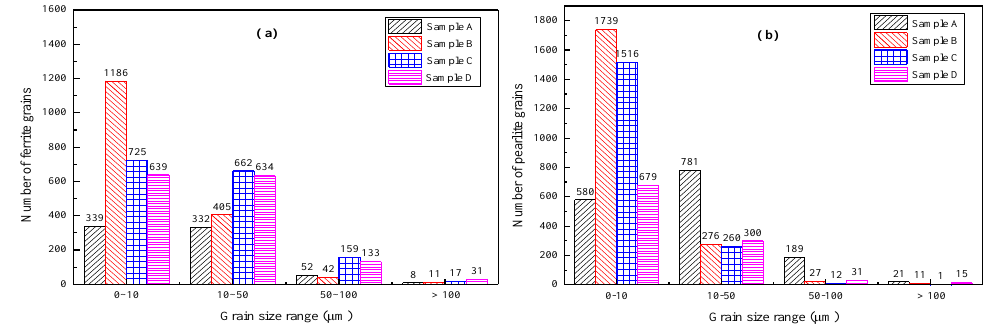
Figure 4. Particle size distribution in the microstructure of various high-rise structural steel samples. ( a ) Ferrite particle size distribution, ( b ) pearlite particle size distribution.